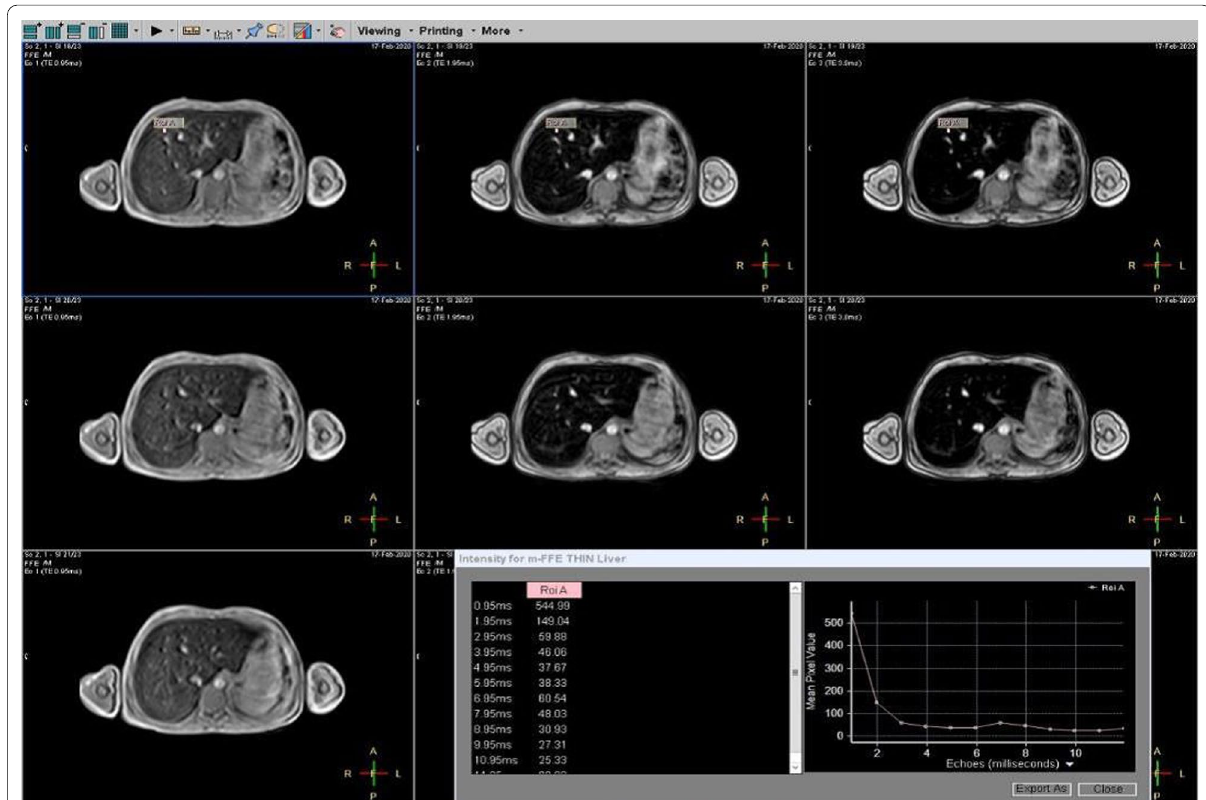
Fig. 2 MRI T2* in a 13-year-old male child with thalassemia major demonstrating moderate hepatic iron overload denoted by a dark signal in the